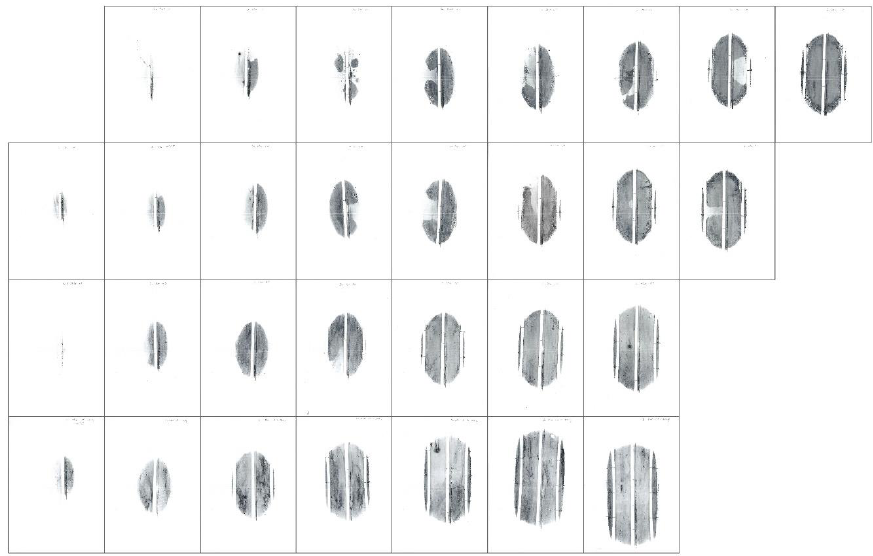
Figure 10. Negatives of wheel-to-surface contact areas for the Su-22 wheel. Coatings 2020 , 10 , x FOR PEER REVIEW